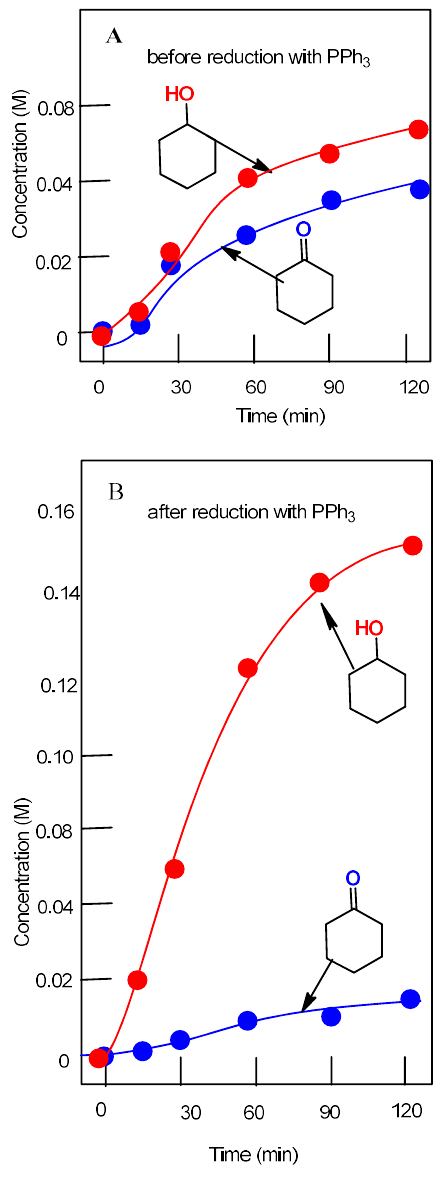
Figure 8. Accumulation of cyclohexanol and cyclohexanone in the oxidation of cyclohexane (0.46 M) with H 2 O 2 (2.0 M) catalyzed by complex 3 (5 × 10 −4 M) at 50 °C in acetonitrile. Concentrations of products were measured by GC before ( A ) and after ( B ) the reduction of the reaction samples with solid PPh 3 .